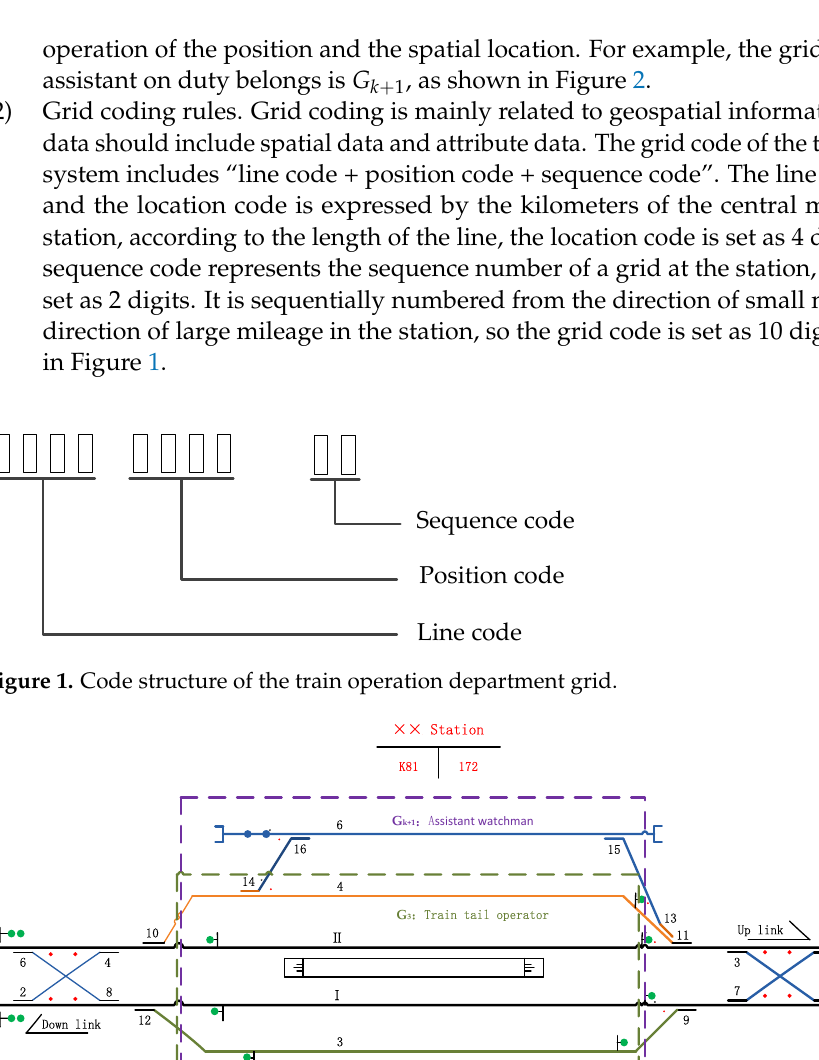
Figure 2. Code structure of the train operation department grid. 3.2. Definition and Coding of Grid Elements The individual workers and equipment contained in the transportation system grids are collectively referred to as the elements of the grids. This study focuses on the special element of “individual worker”. Element coding generally includes employee infor- mation and geospatial information. The employee code is used to determine the work type of the employee, and the geospatial code is used to determine the location of the